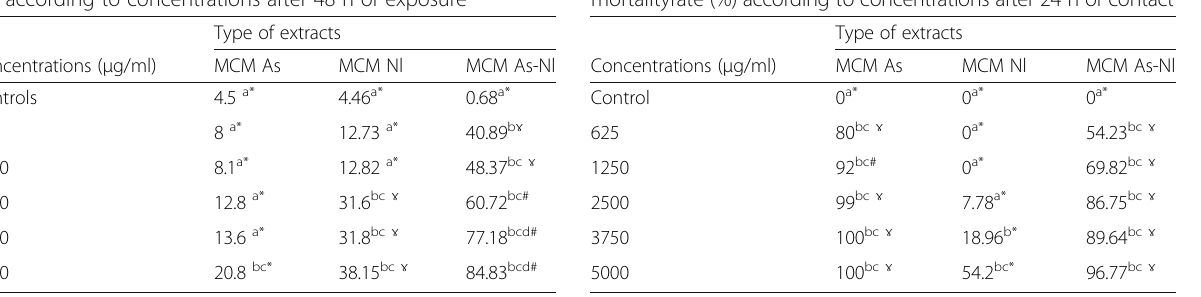
Means in the different concentrations (columns) and signs of the type of extract (rows) followed by the same letters and symbols are not significantly different at 5% probability